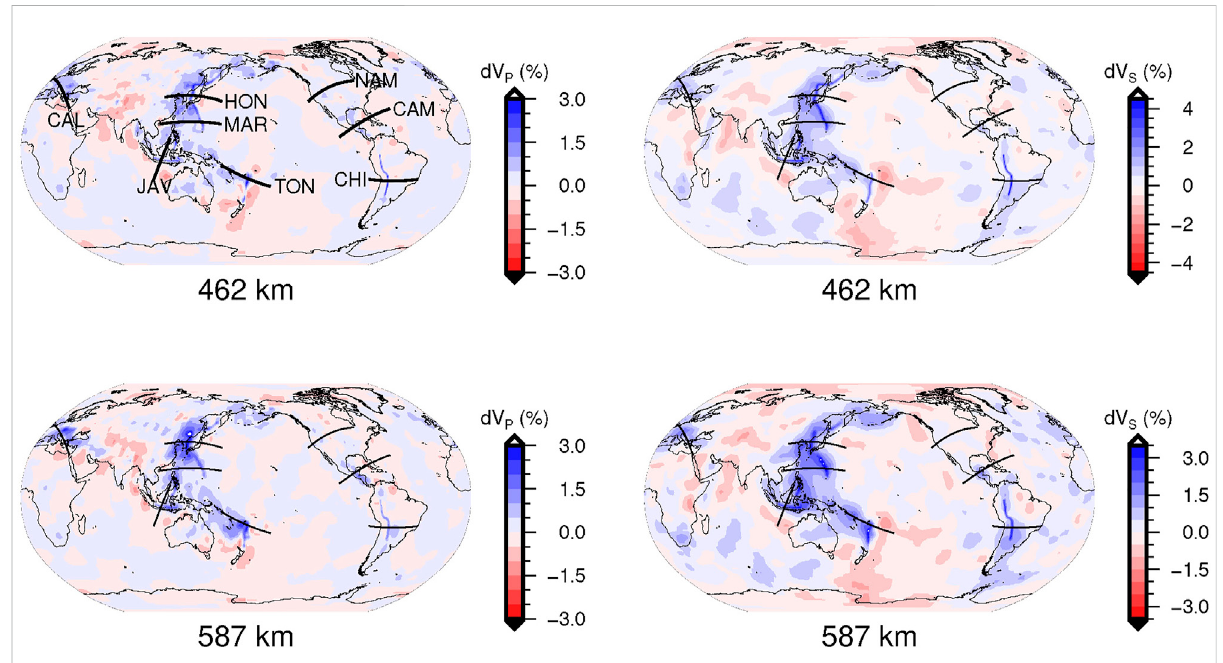
FIGURE 4 Isotropic P-wave and S-wave velocity anomalies in the upper and lower MTZ for TX2019slab (Lu et al., 2019). Eight black lines represent the subducting directions of slabs in eight subduction zones. They are the HON, MAR, TON, JAV, CHI, NAM, CAM, and CAL subduction